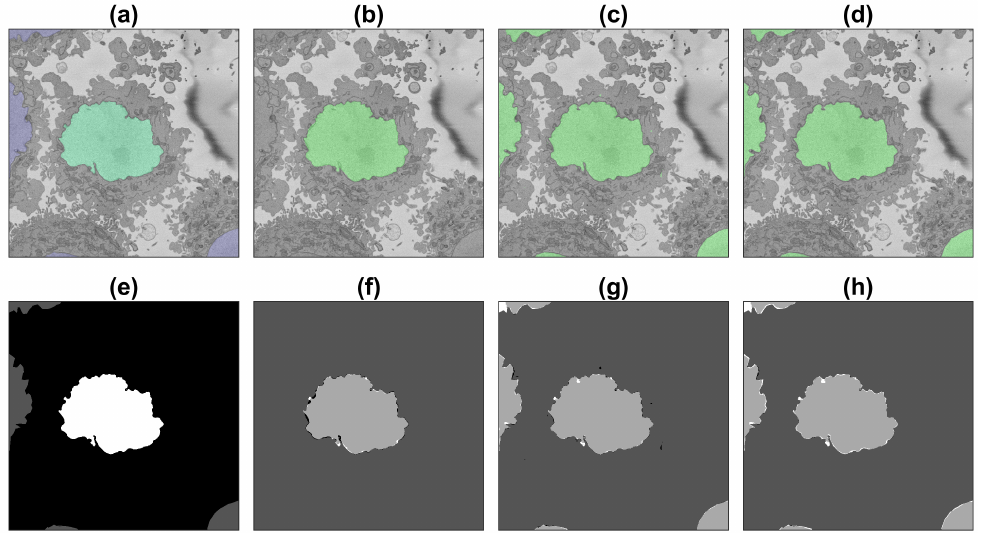
Figure 9. Illustration of the semantic segmentation of one slice (71/300) of the region of interest (ROI) with the image processing (IP) algorithm and U-Net trained with 135,000 patches. For a description of ( a – h ), see Figure